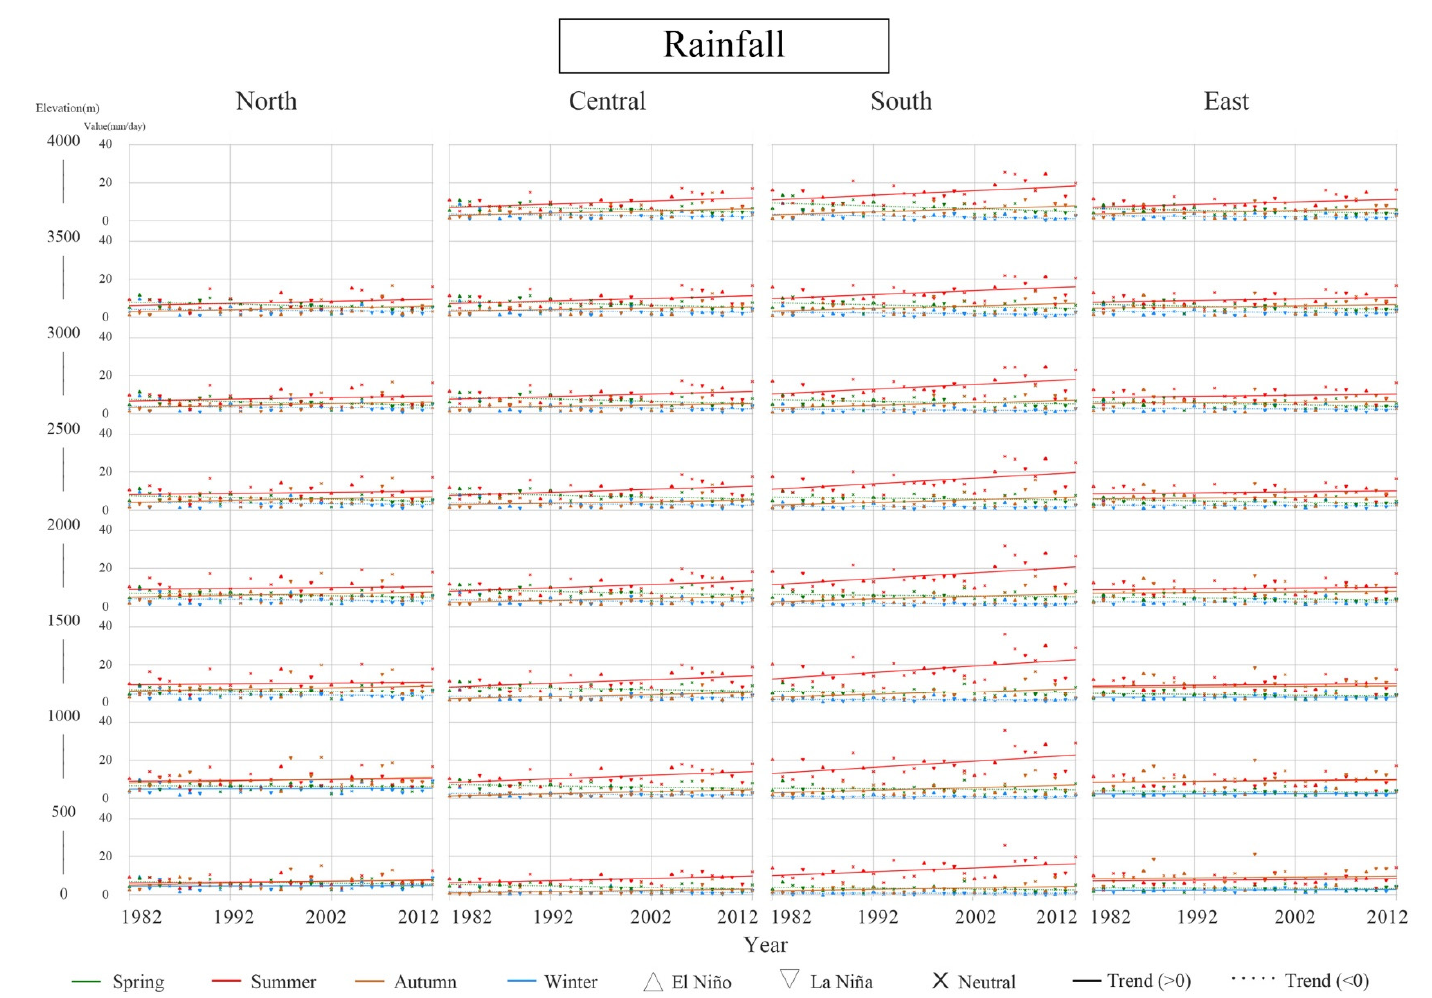
Figure 10. Regional and seasonal linear regression results for rainfall at varied elevations.